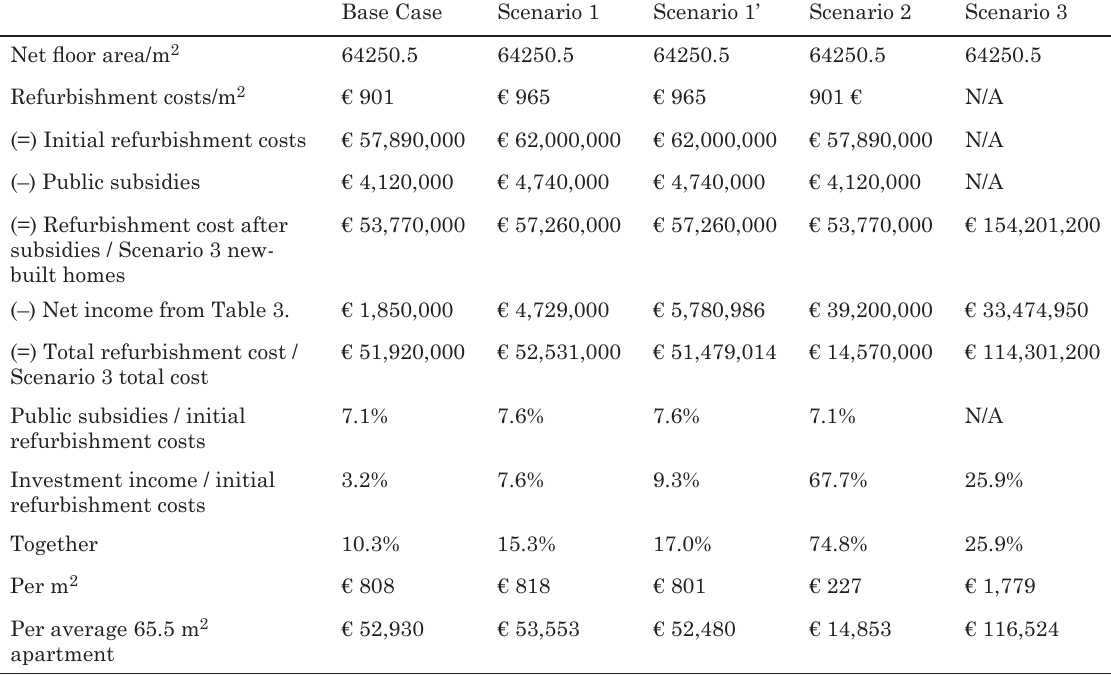
table 4. Summary of refurbishment/redevelopment cost scenarios (new-built costs in Scenario